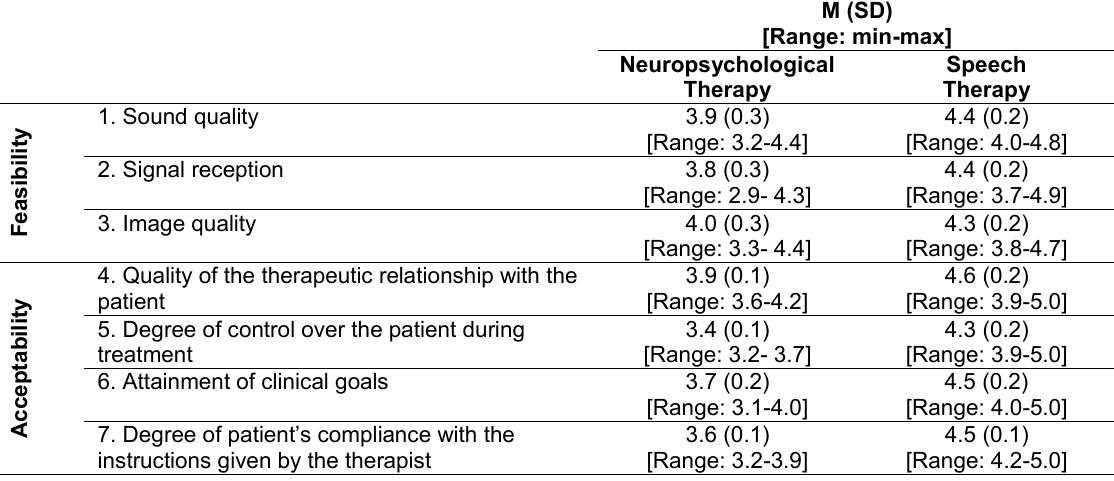
Total Means, SDs, and Range in the Therapists’ Questionnaires Assessing Feasibility and Acceptability, for Neuropsychological and Speech